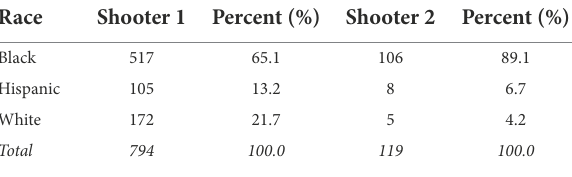
TABLE 4 Race of mass shooters in study’s final subsample.